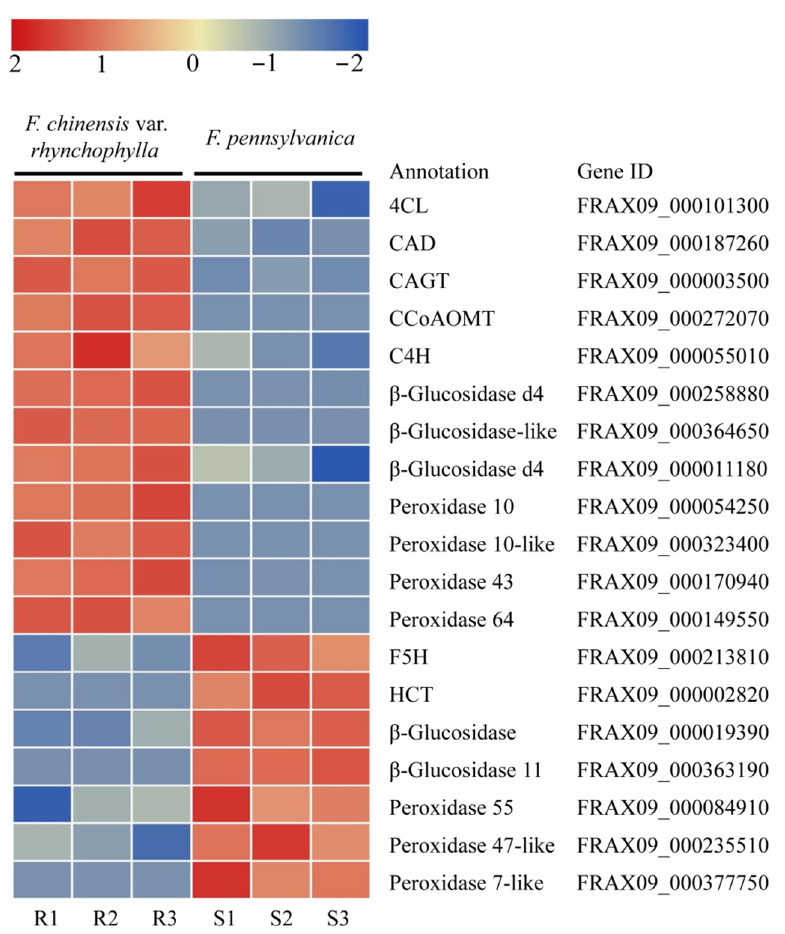
Figure 3. Heatmap of DEGs related to phenylpropanoids biosynthesis. R1, R2, and R3 represent three replicates of resistant F. chinensis var. rhynchophylla . S1, S2, and S3 represent three replicates of susceptible F. pennsylvanica . 4CL, 4-coumarate: coenzyme A ligase; CAD, coniferyl-aldehyde dehydrogenase; CAGT, coniferyl alcohol glucosyltransferase; CCoAOMT, caffeoyl-CoA O-methyltransferase; C4H, cinnamate-4-hydroxylase; ferulate-5-hydroxylase; HCT, shikimate